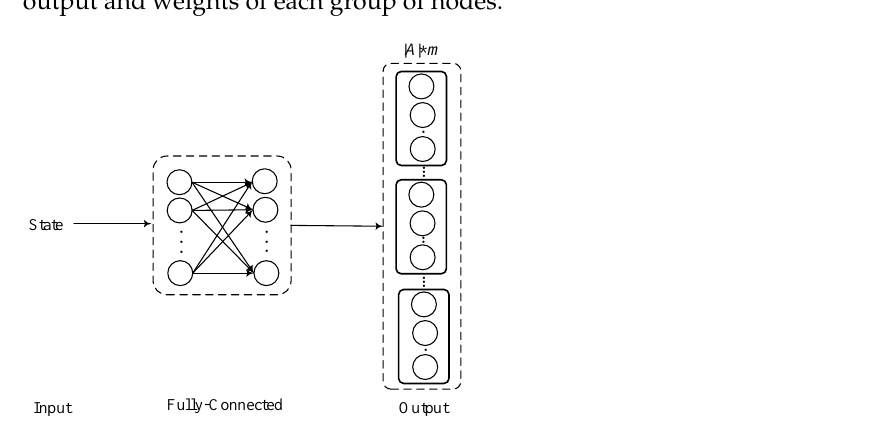
Figure 1. Standard MODRL framework. First, the agent takes the currently observed state as the input, then through two fully connected layers. Finally, it outputs n sets of optimization targets for action